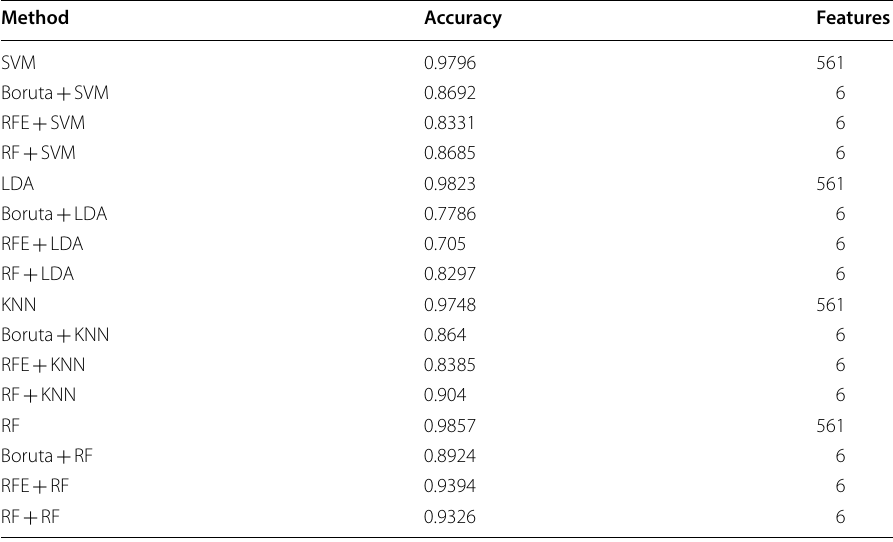
Table 12 Classification accuracy of different classifiers with human activity recognition using smartphones dataset